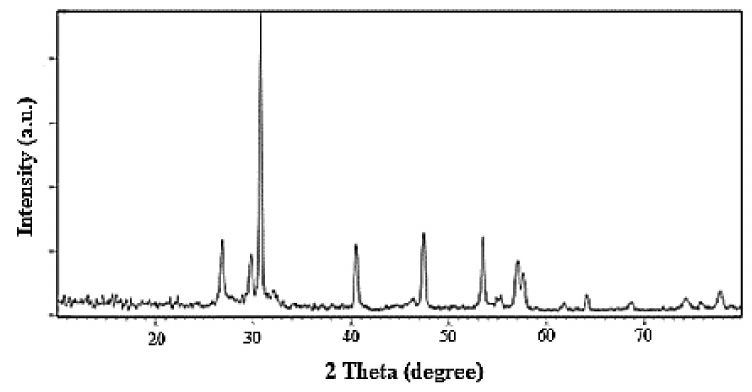
Figure 5. X-ray di ff raction (XRD) pattern of the Nd 2 O 3 nanoparticles. The XRD pattern indicates that the maximum peak is around 2 θ = 31